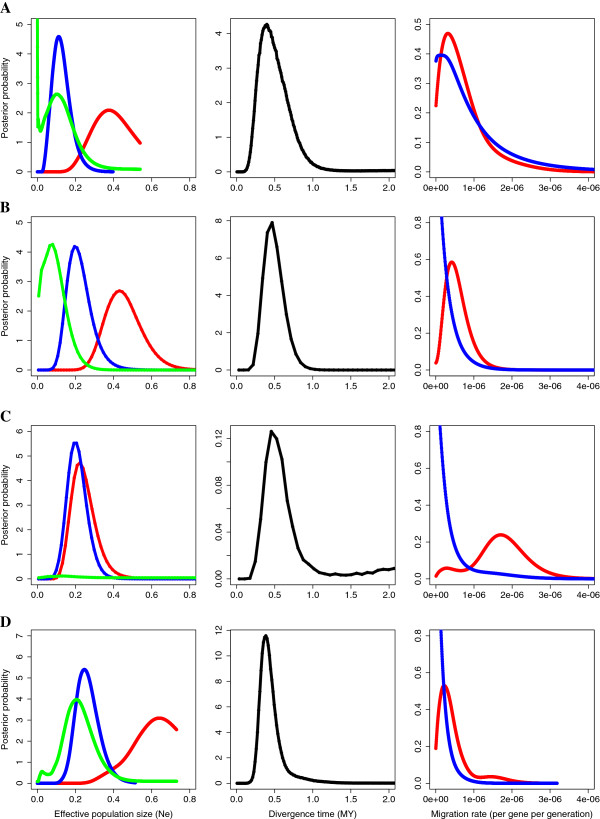
Posterior probability distributions of the six parameters estimated using the isolation-migration model. Left panel is current (pied flycatcher = blue, collared flycatcher = red) and ancestral (green) effective population size estimates in millions, middle panel is time of divergence in million years and right panel is post-divergence migration rates (per gene per generation) from pied flycatcher to collared flycatcher (red) and from collared flycatcher to pied flycatcher (blue). A) allopatric Spanish pied flycatcher and Italian collared flycatcher, B) allopatric Spanish pied flycatcher and Hungarian collared flycatcher, C) sympatric pied flycatcher and collared flycatcher from the Baltic Sea islands and D) between species comparison including data from all populations within each species.